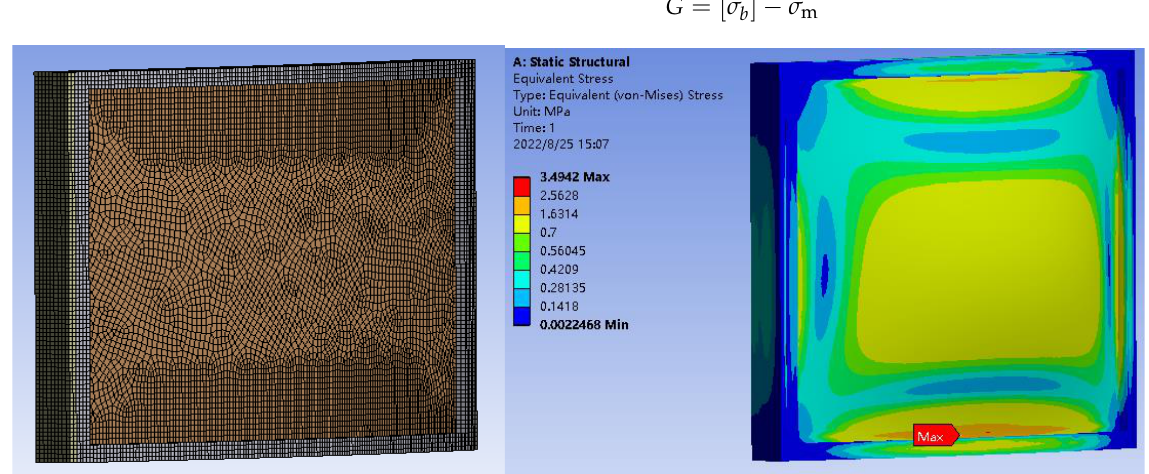
Figure 11. Finite element model of the aquarium and the stress distribution of the result.